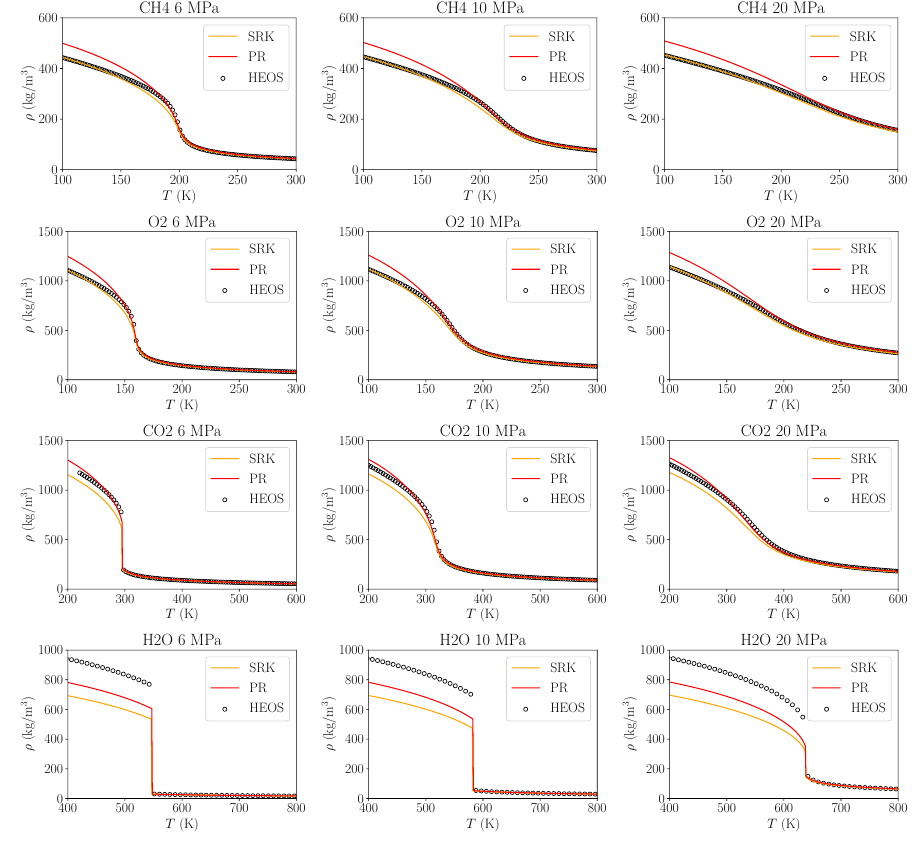
Figure 4. Comparison of Peng–Robinson and Soave–Redlich–Kwong EOS to reference data for density ρ of, from top to bottom, methane, oxygen, carbon dioxide, water; at three different pressures from left to right p = [ 6,10,20 ]